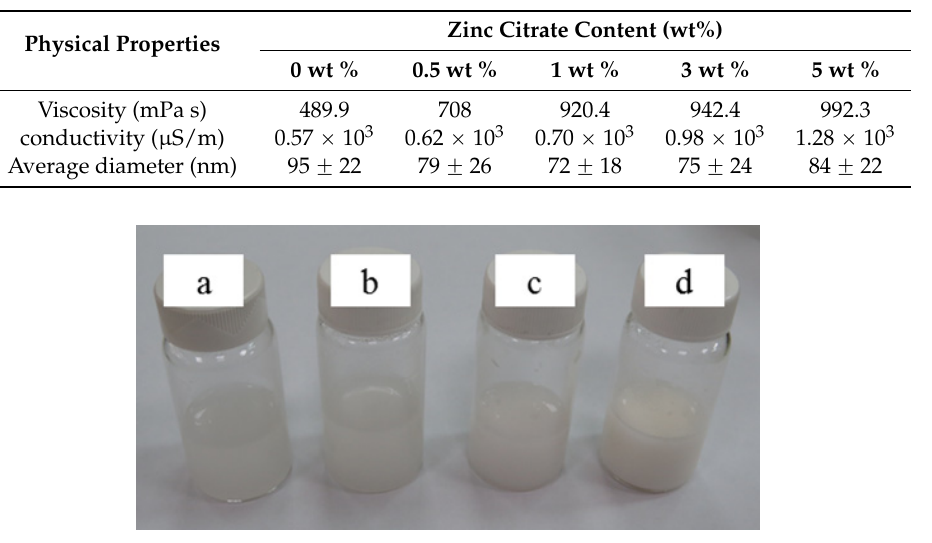
Figure 3. The dispersion of zinc citrate in PVA/zinc citrate mixtures that contain ( a ) 0.5 wt %; ( b ) 1 wt %; ( c ) 3 wt %; and ( d ) 5 wt % zinc citrate. The mixtures are kept at room temperature a fortnight.